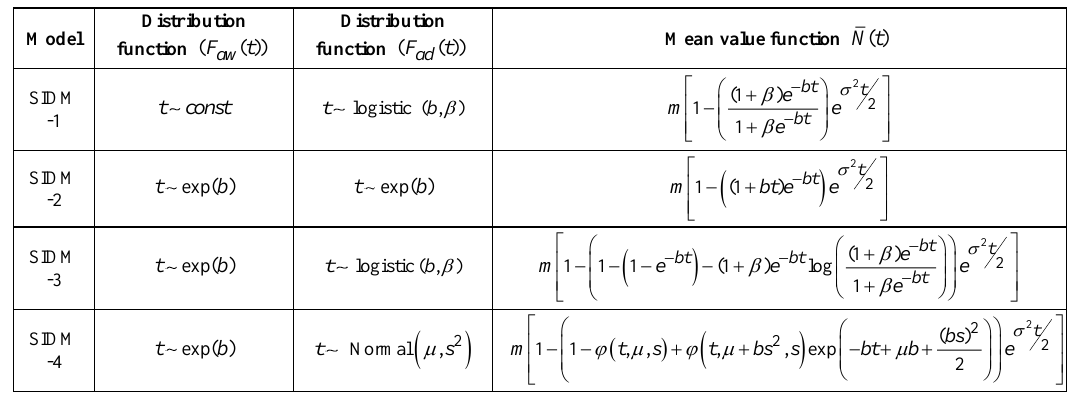
Table 1. Proposed diffusion